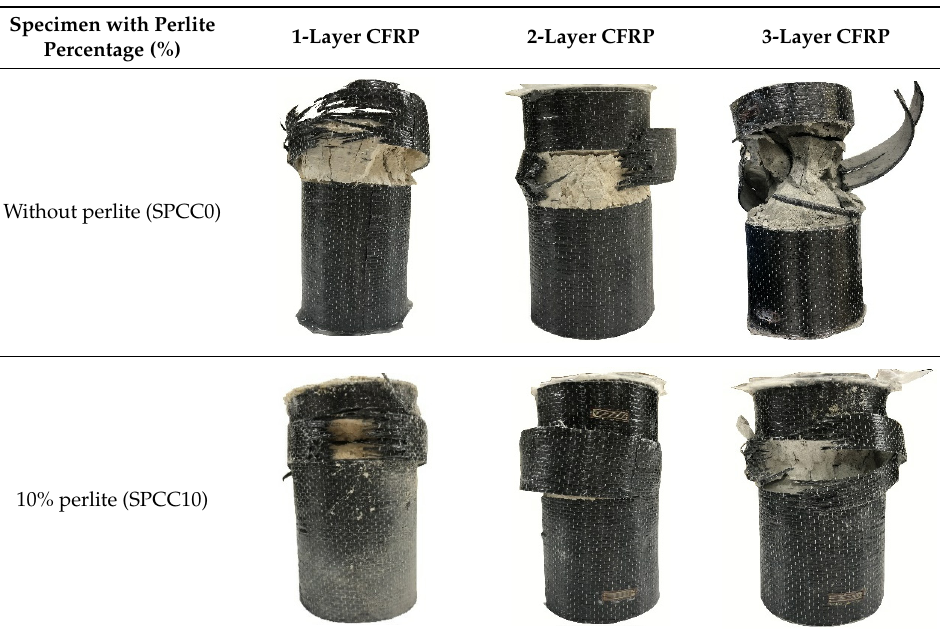
Table 11. Post-test photos of SPCCs.